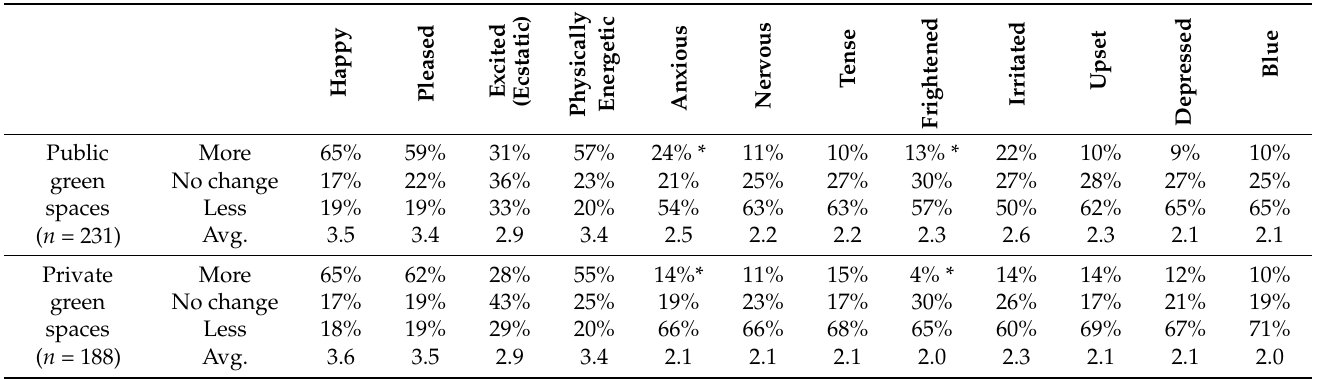
Table 2. Feelings of people who visited a public (upper part) or a private (lower part) green space.